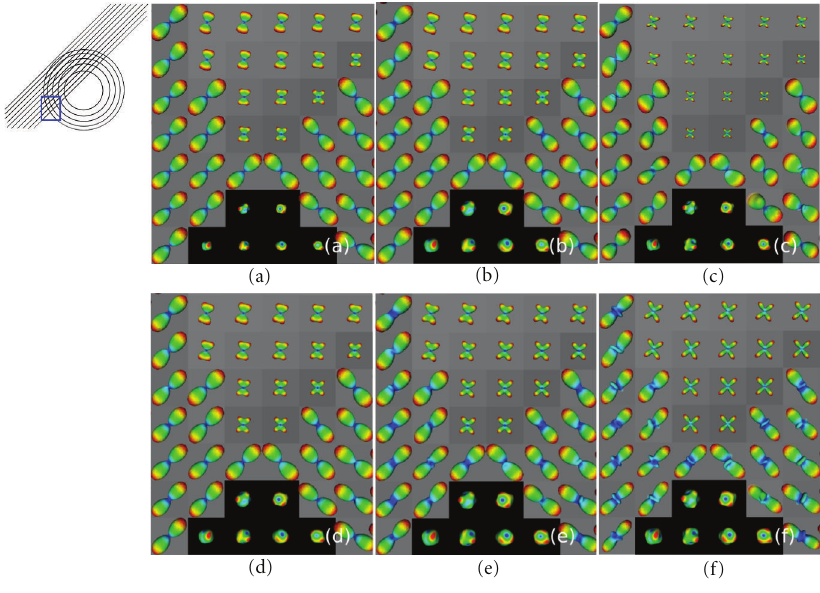
Figure 5: E ff ects of the approximating order n and the probability radius | r | . In top row, | r | is fixed, and we vary n . In bottom row, n is fixed, and we vary | r | . Top row: | r | = 16 μ m: (a) Pr (5) 4,4 , (b) Pr (7) 4,4 , and (c) Pr (9) 4,4 . Bottom row: n = 7 (Pr (7) 4,4 ): (d) ≡ (b) | r | = 16 μ m, (e) | r | = 18 μ m, and | r | = 20 μ m.